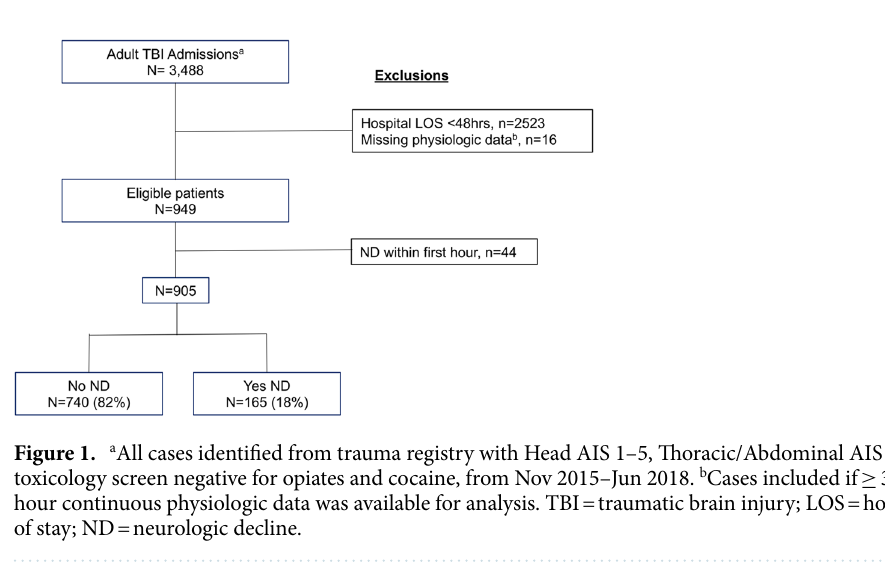
Clinical factors found to be associated with ND on univariate analysis included penetrating injury ( P < 0.001) and lower GCS ( P < 0.001). Inpatient clinical characteristics and hospital discharge outcomes of patients grouped by primary outcome are described in Table 2. Patients who developed ND had a higher incidence of invasive ICP monitoring, higher in-hospital mortality, lower discharge rates to home, and longer hospital lengths of stay ( p < 0.001). Initial head CT findings are reported in Supplemental Table 2.